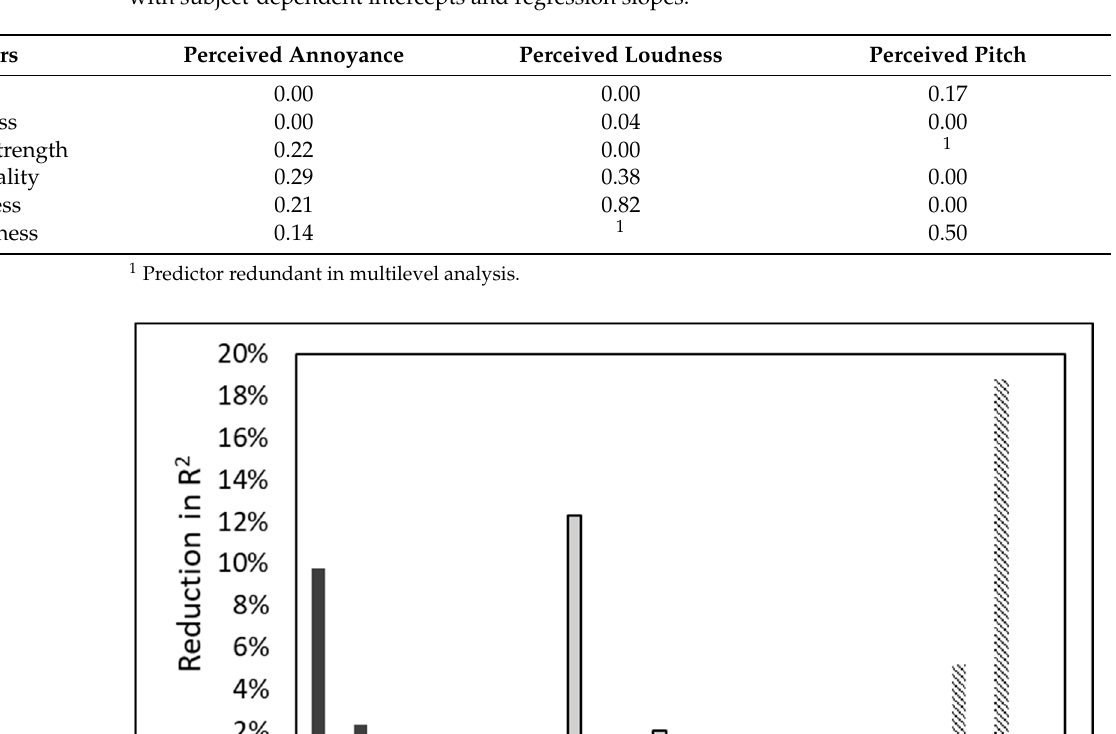
Table 9. Statistical significance ( p -value) of predictors for perceived annoyance, loudness and pitch with subject-dependent intercepts and regression slopes.